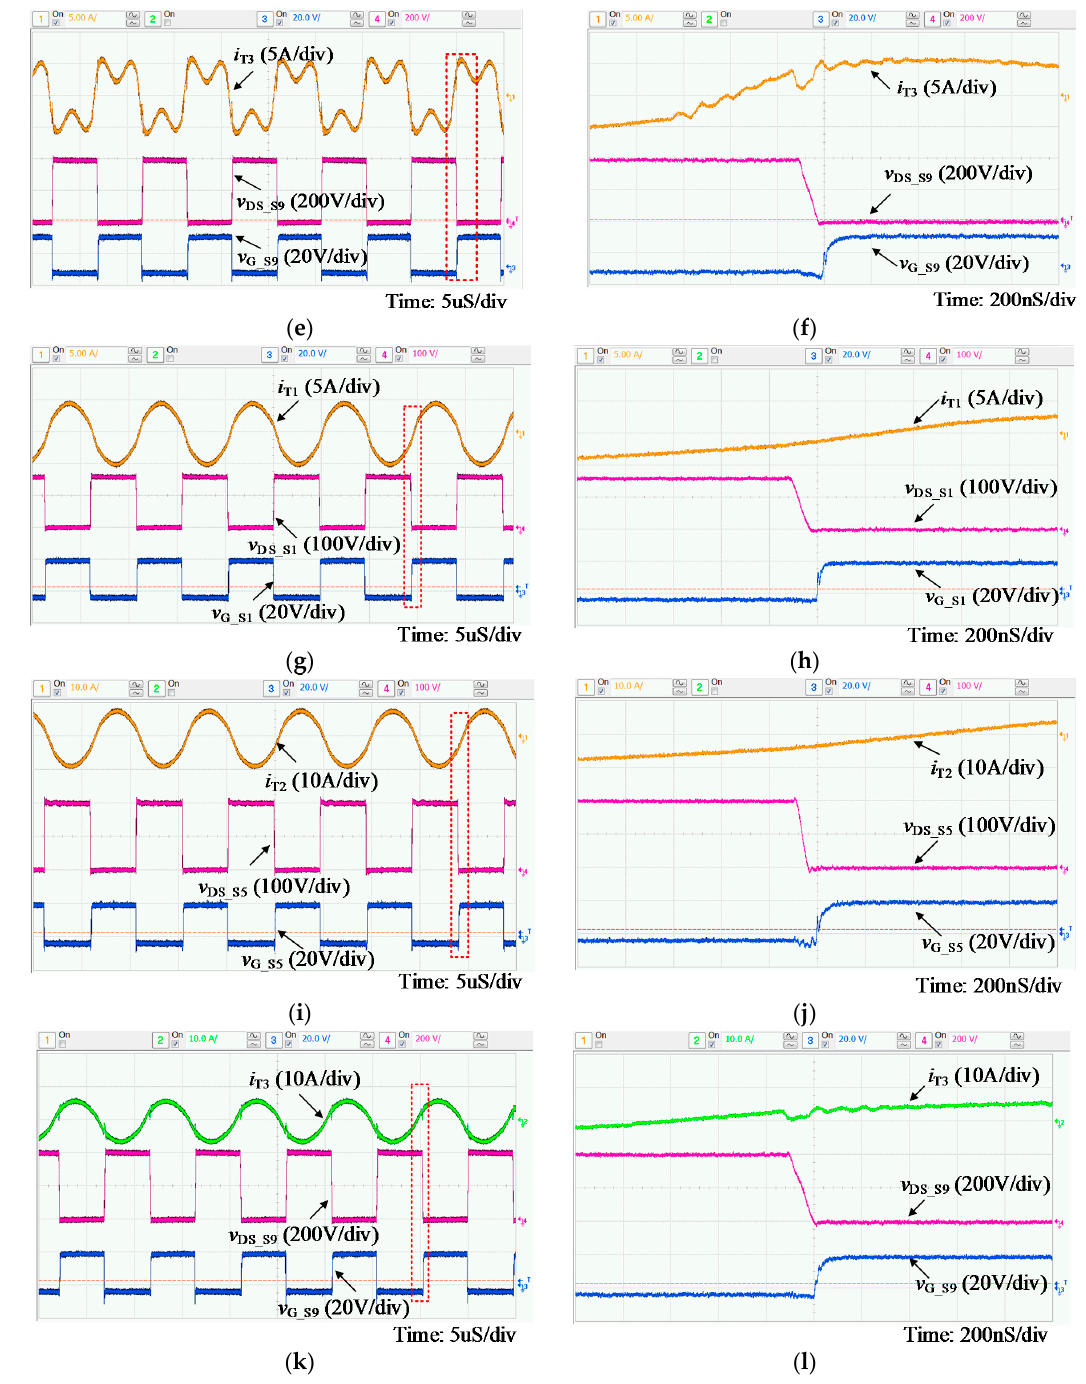
Figure 14. Experimental results of MR-TP-BDC and SR-TBC under rated condition: ( a , b ) bat; ( c , d ) sc ( e , f ) bus MR-TBC; ( g , h ) bat; ( i , j ) sc; ( k , l ) bus SR-TBC. i T1 , i T2 and i T3 are the three-port currents of transformer. i Lp1 and i Lp2 are the parallel resonant inductance current. v DS_S x represents the drain-source voltage of MOSFET S x ( x is 1–9). v G_S x is the